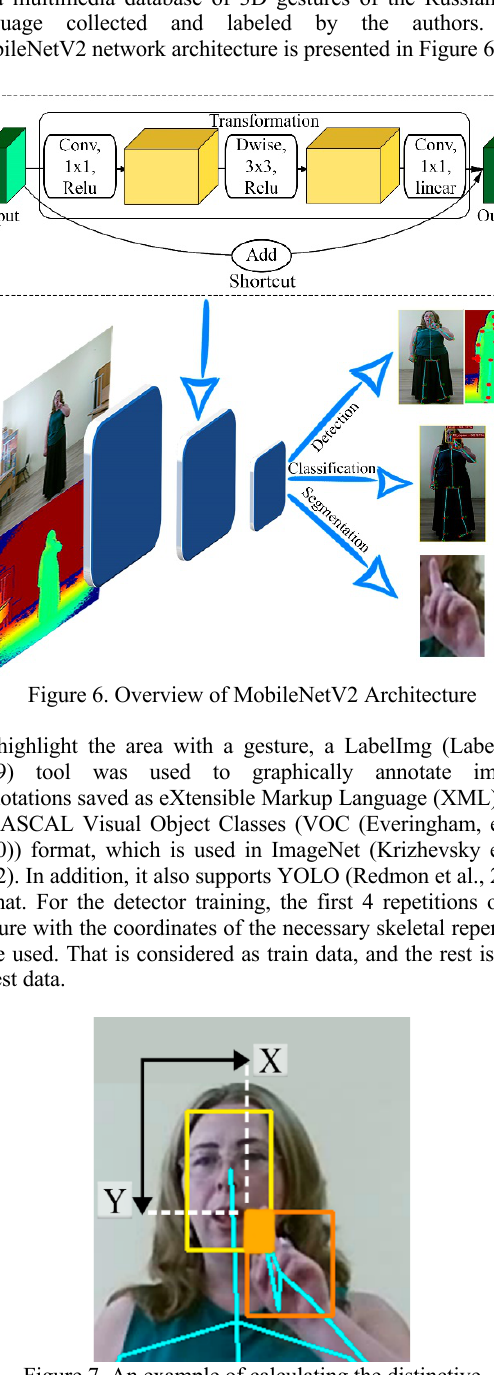
Figure 7. An example of calculating the distinctive characteristics of a gesture at a certain point in